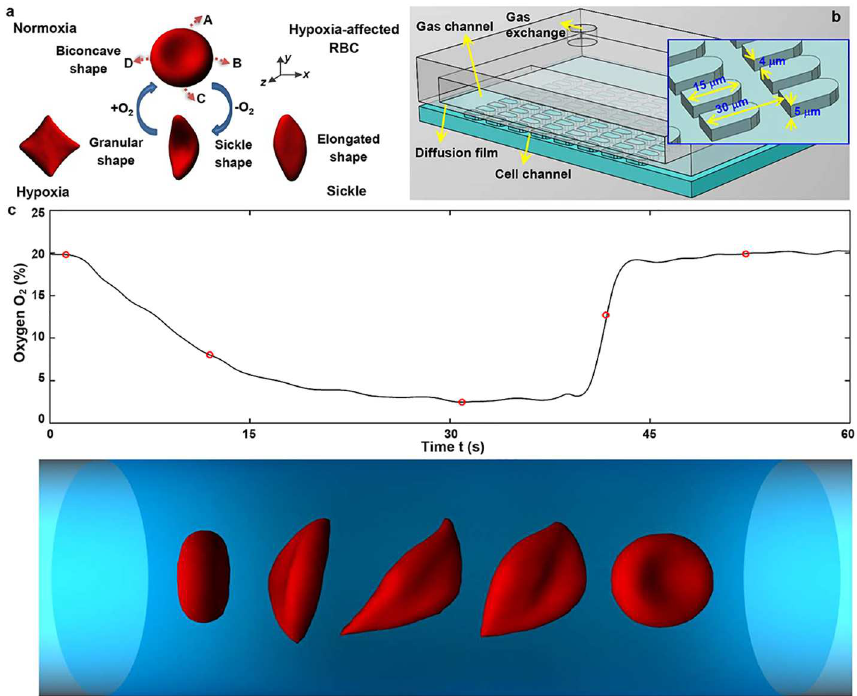
Fig 1. Time-dependent cell morphological sickling model. (a) Morphologicaltransition of RBCs from the biconcaveto different sickle shapes under transient hypoxic conditions. Labels A – D representthe position of the anchorpoints, which are represented by ε N v ( ε = 0.016) vertices. (b) Schematic of microfluidicdevice with O 2 control for kinetics of cell morphologicalsicklingand unsicklingas well as singlecell biorheology test. The microfluidic channelcontainsperiodicobstacles forming 15- μ m-long,4- μ m-wideand 5- μ m-highmicrogates, mimicking the size of the smallest capillariesin human body. (c) Cell sicklingand unsickling process in responseto changein O 2 concentration as a function of time (from companionexperiments). Simulations of five sequentialsnapshotsof the RBC shapeevolutionat O 2 % = 19.8%, 8.1%, 2.5%, 12.7%, and 19.9%, from left to right. These conditions correspond to the red circles indicatedin the O 2 versus time plot. See S1 Video for dynamic shapechangesoccurringin responseto alterationsin oxygen